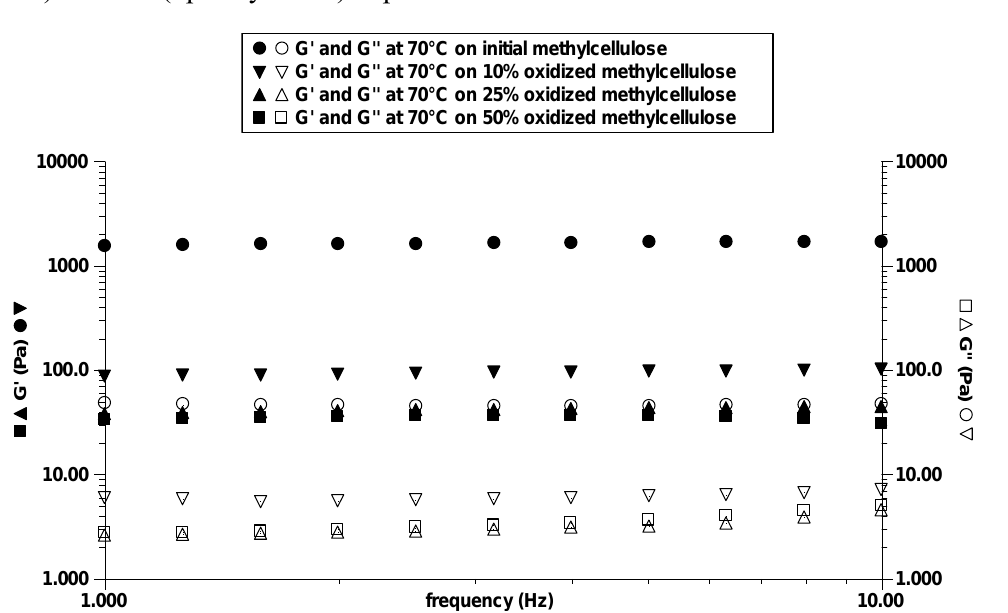
Figure 8. Dynamic rheology at 70 °C for initial methylcellulose and the oxidized samples at 30 g/L in water. ME 10 (10% ox); ME 25 (25% ox); ME 50 (50% ox). G’ (filled symbols) and G’’ (open symbols) expressed in Pa.